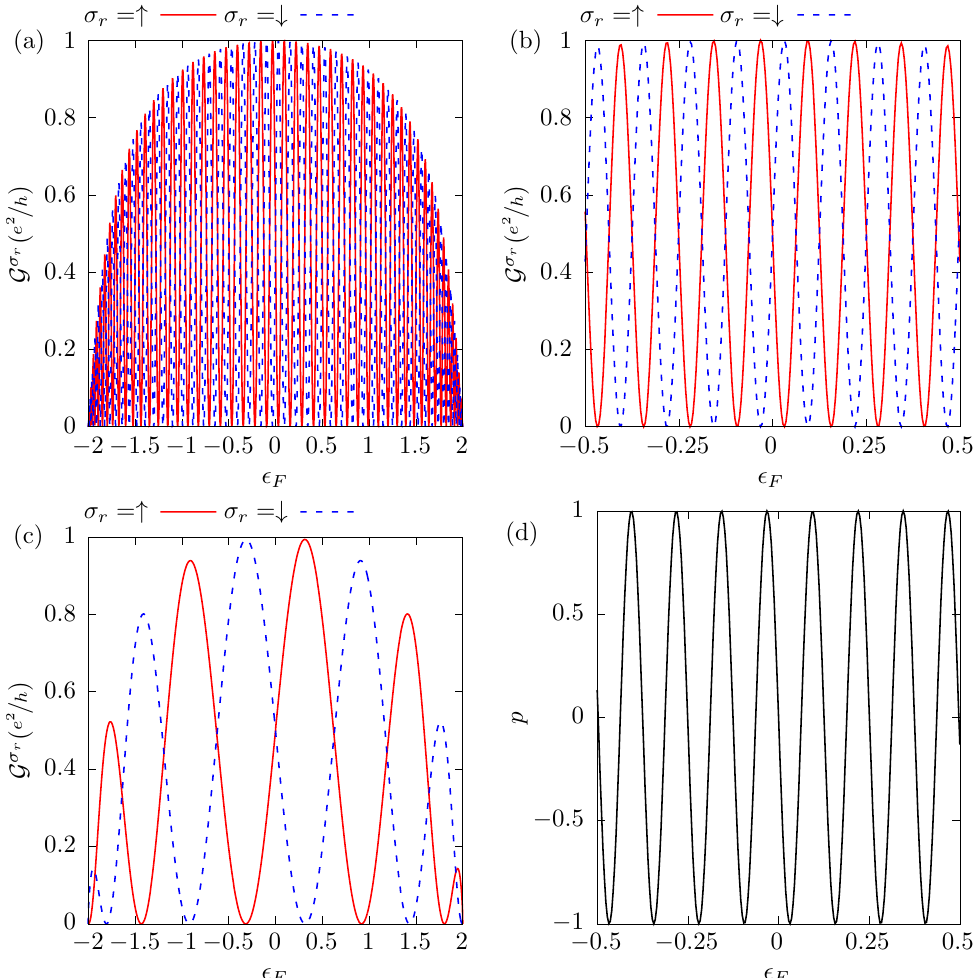
σ r for each spin σ Figure 3. The conductance r , panels ( a – c ), and the spin polarization of the current p , G panel ( d ), as a function of the Fermi energy (cid:101) F . Panels ( a , b , d ) correspond to a system with R = 100 a , α = 1.212 10 − 2 t and β = 10 − 2 t , while in panel ( c ) the parameters are R = 10 a , α = 0.158 t , and × β = 10 − 2 t . For both configurations, t (cid:48) = t